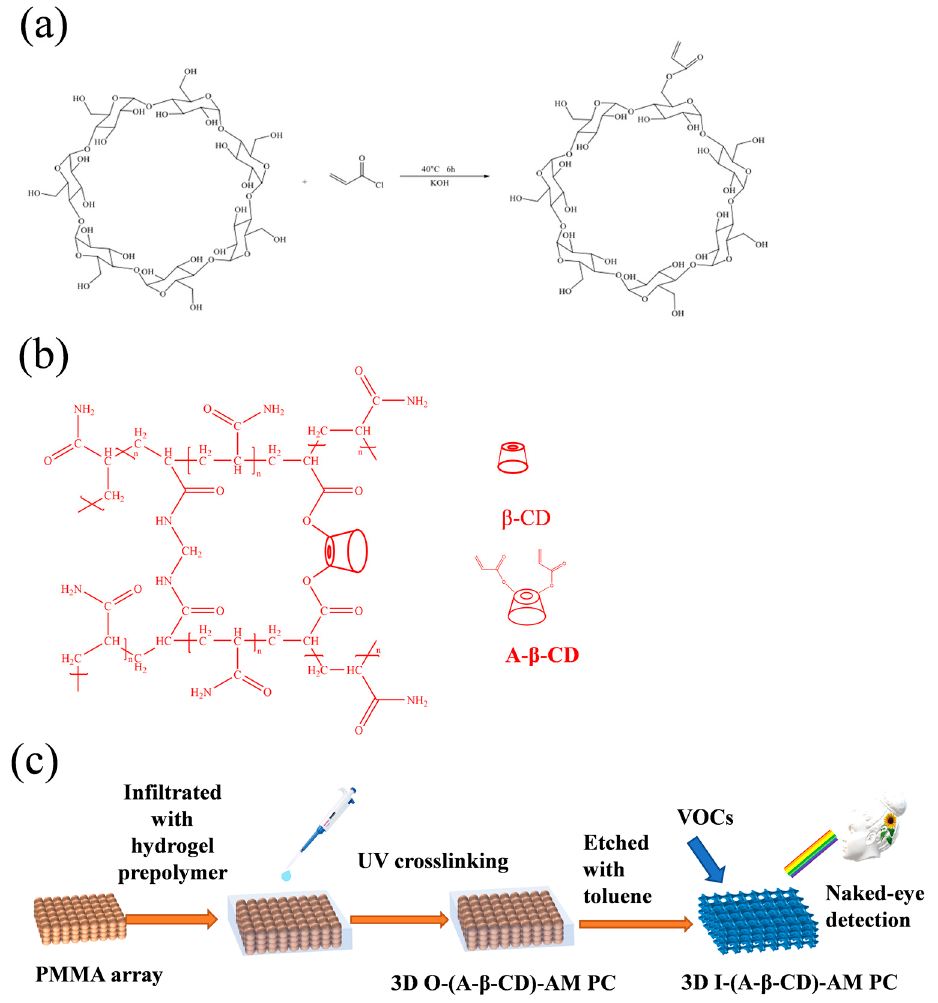
Figure 1. ( a ) The synthetic route of A- β -CD; ( b ) the chemical structure of the hydrogel formed by free radical polymerization; ( c ) schematic illustration of the (A- β -CD)-AM PC